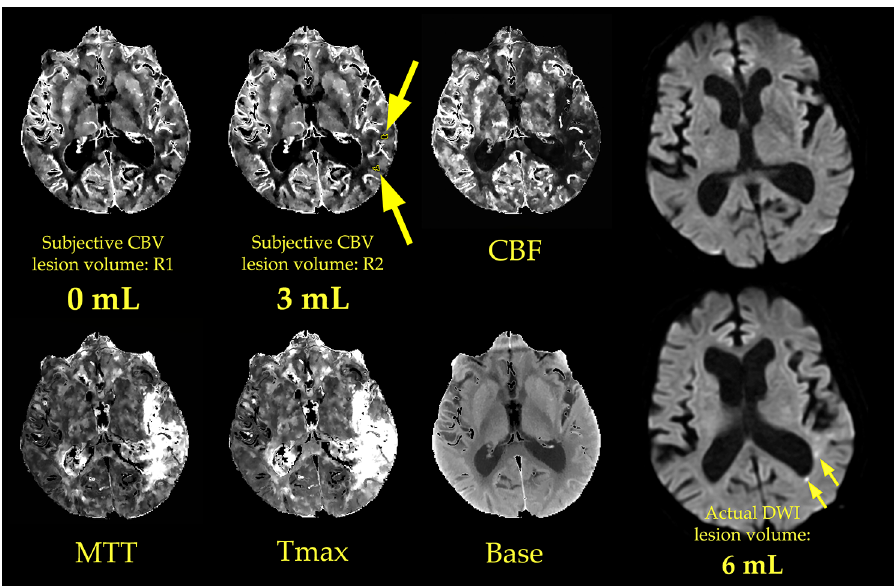
Fig 4. Subjective measurement of CBV lesion volume in a second patient. Two radiologists (R1 and R2) subjectively outlined regions of abnormally low CBV. In doing so, the radiologists had access to all available CTP images, and to clinical history (in this case, “ aphasia and right face, arm, and leg weakness ” ). The patient and CT slice location are the same as those in Fig 3. R1 did not detect a lesion, i.e. he measured the core lesion volume to be 0 mL. R2 outlined several lesions (yellow outlines and large arrows) whose total volume was 3 mL. Although R2 ’ s subjective lesion volume was very close to the actual DWI lesion volume of 6 mL, none of the CBV lesions that R2 outlined corresponded to actual DWI lesions. No lesions were present in a DWI image obtained at approximately the same level as these CTP maps (upper right), and all of the DWI lesions that were present were located more superiorly (lower right, small arrows).